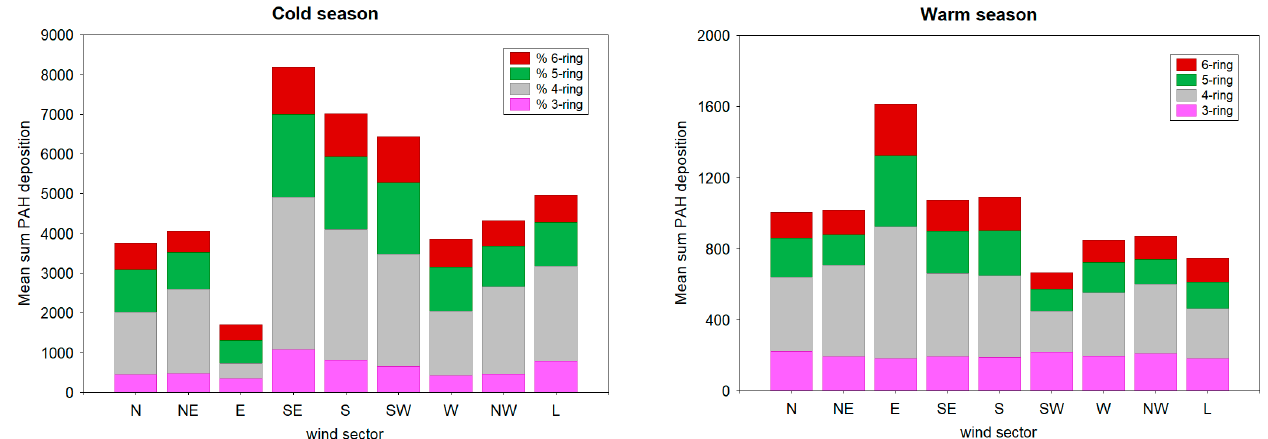
Figure 4. The cumulative mean sum of PAH deposition fluxes in relation to the wind sector during the cold and warm seasons.